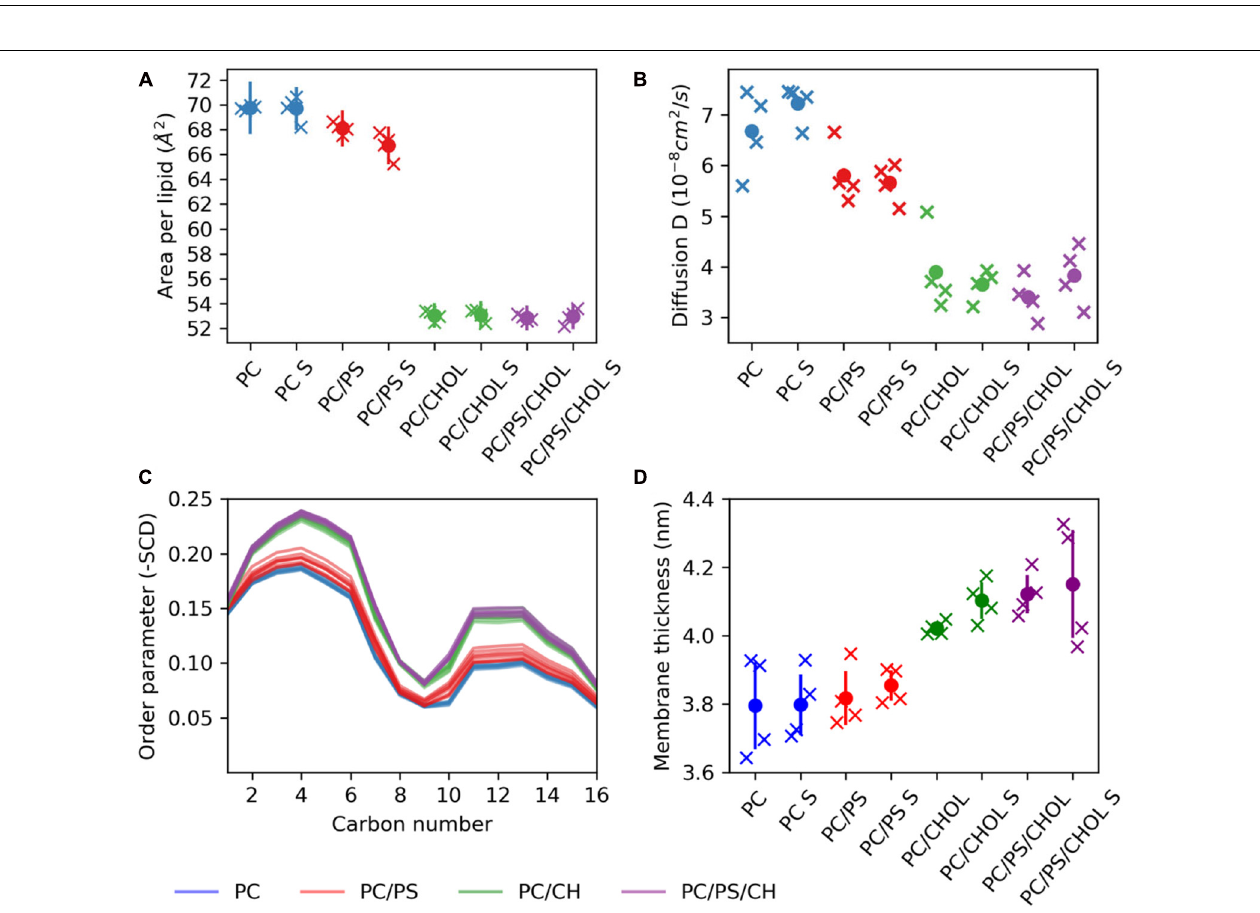
FIGURE 8 | Membrane properties. (A) Area per lipid. (B) Diffusion coefficient. (C) Order parameter (D) Membrane thickness. The properties are shown for each simulation series (each individual simulation marked by an X), with S indicating the simulation series with IAPP starting in the straight